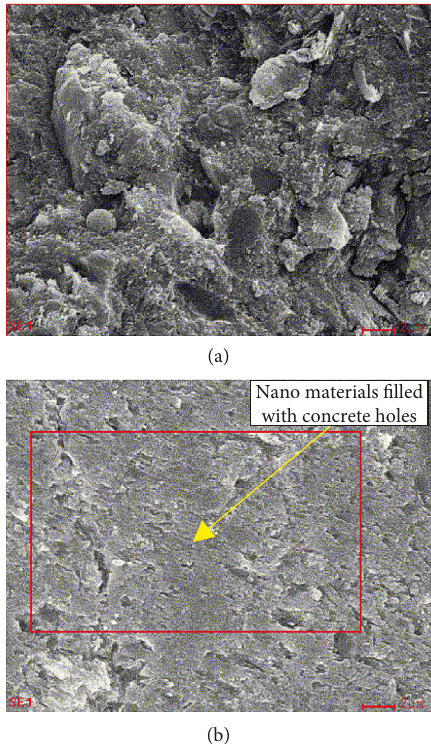
Figure 10: Comparison of concrete microstructures for concrete without and with nano-SiO 2 : (a) microstructure of concrete without nano-SiO 2 ; (b) microstructure of concrete with nano-SiO 2 .